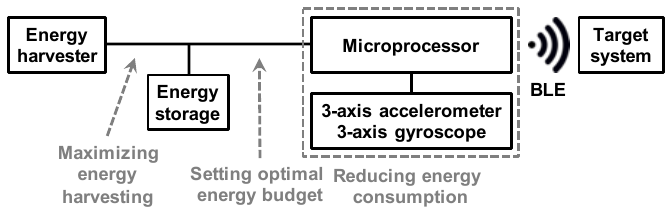
Figure 1. Proposed wearable gesture recognition system. BLE: Bluetooth Low